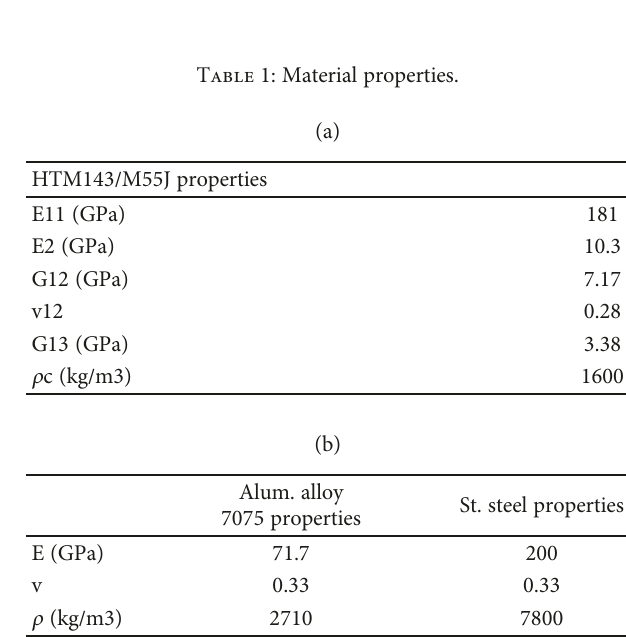
Figure 1: CAD design for the “ hybrid ” structure (a) and the fully assembled cubesat (b).